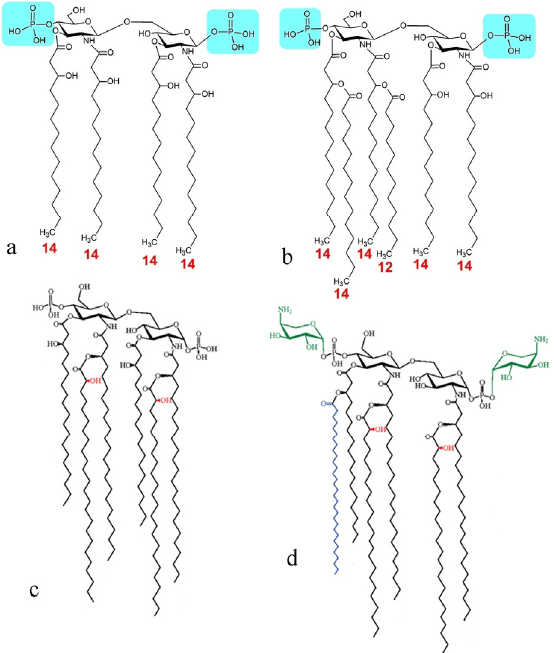
Figure 13. Lipid A portions of the LPS from Yersinia pestis ( a ), Escherichia coli ( b ), and two different forms of Pseudomonas aeruginosa : form A ( c ) and form D ( d ). Adapted with permission from Refs. [107,108].